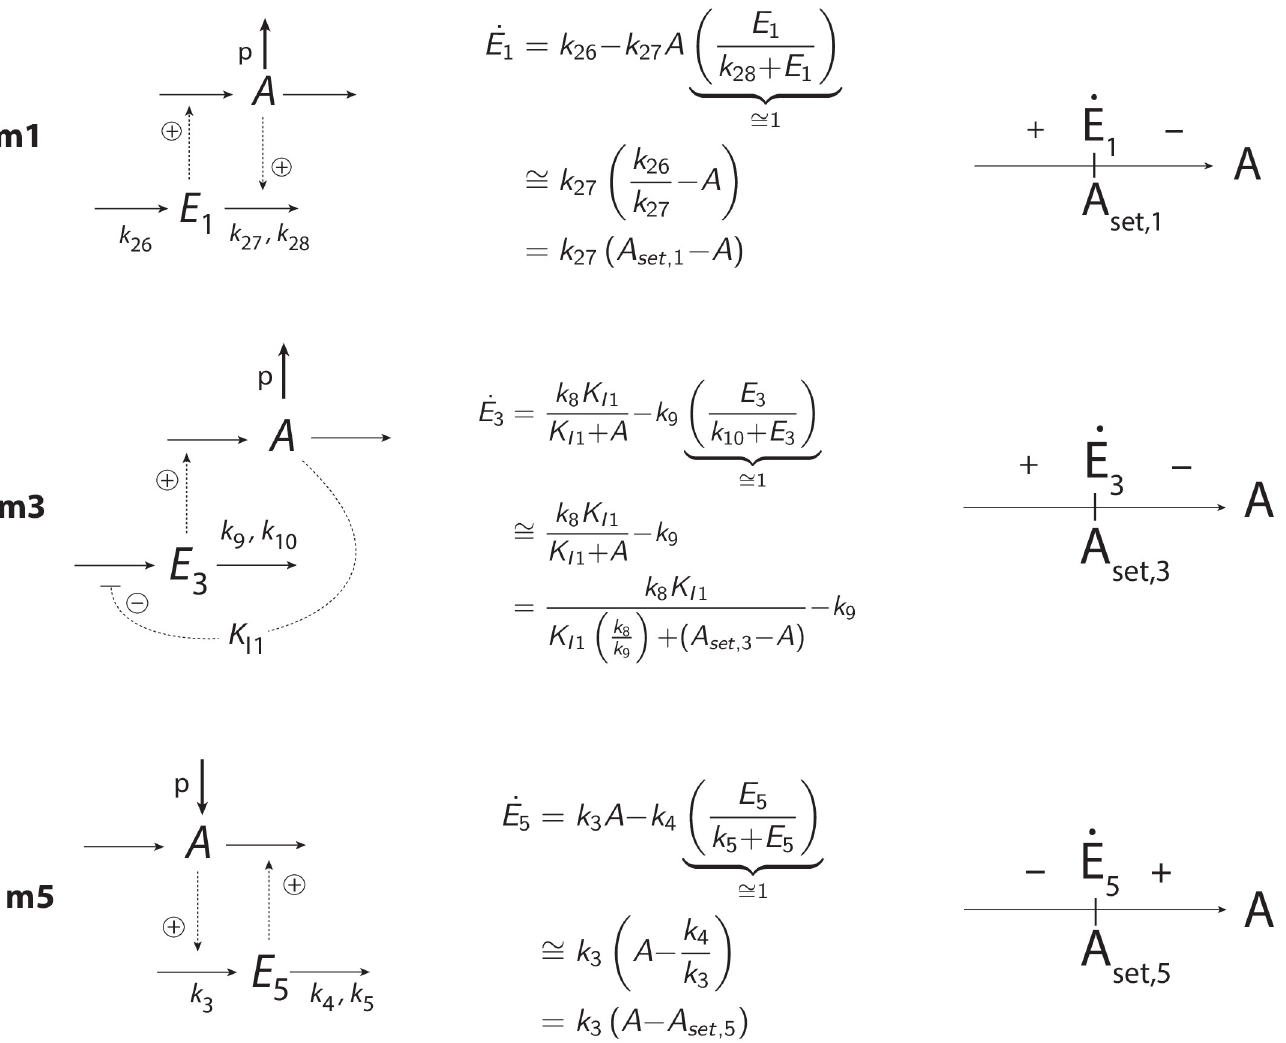
Fig 12. Rate equations of the E i ’s (Fig 1) and their corresponding sign structures _ E with “p” indicate perturbations. When the controlled variable A is at its set-point ( A = A inflow controllers m1 and m3 add more A to the system, while outflow controller m5 removes A from the system. When _ E the E i ’s and their compensatory fluxes go to zero/low